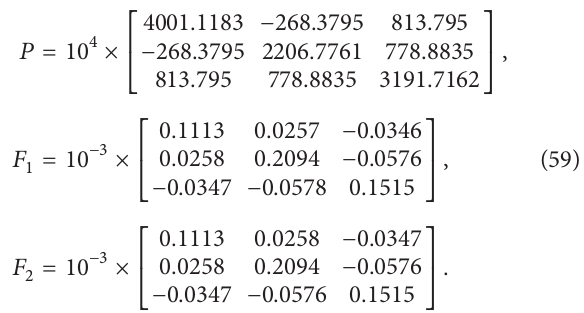
Figure 3: (a) The responses of the best value 𝑡 min of LMI Solver (MATLAB) of −1.135048× 10